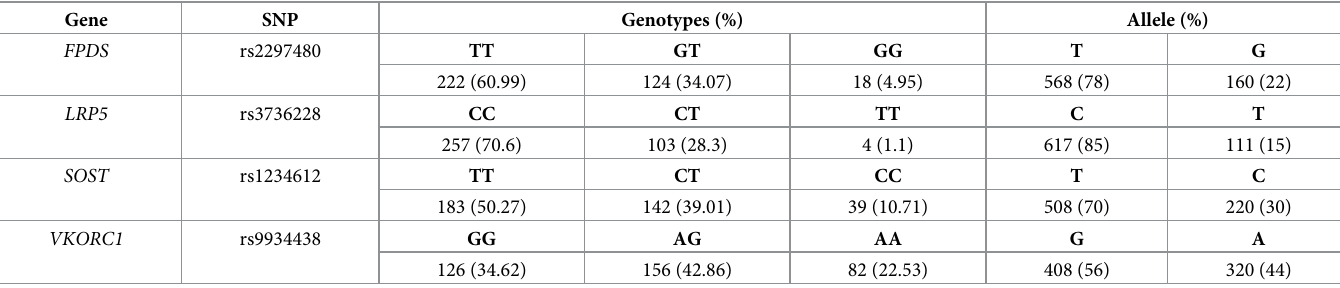
Table 2. Allelic and genotypic frequencies of the SNPs in the study population (n = 364).